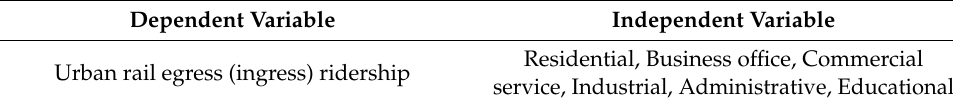
Table 1. Dependent and independent